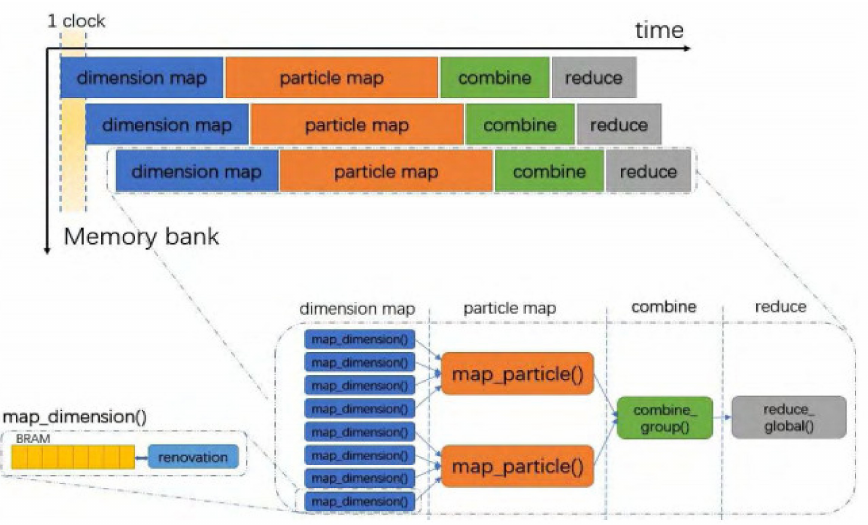
Figure 13. Full pipelined general framework of swarm intelligence (FASI) on FPGA [50]. (Reprinted with permission from ref. [50]. Copyright 2021